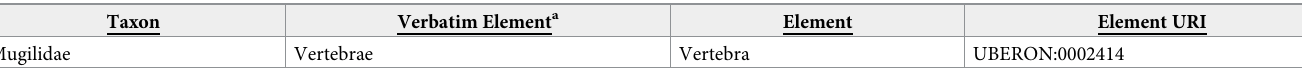
Table 2. Example of the data cleaning process.